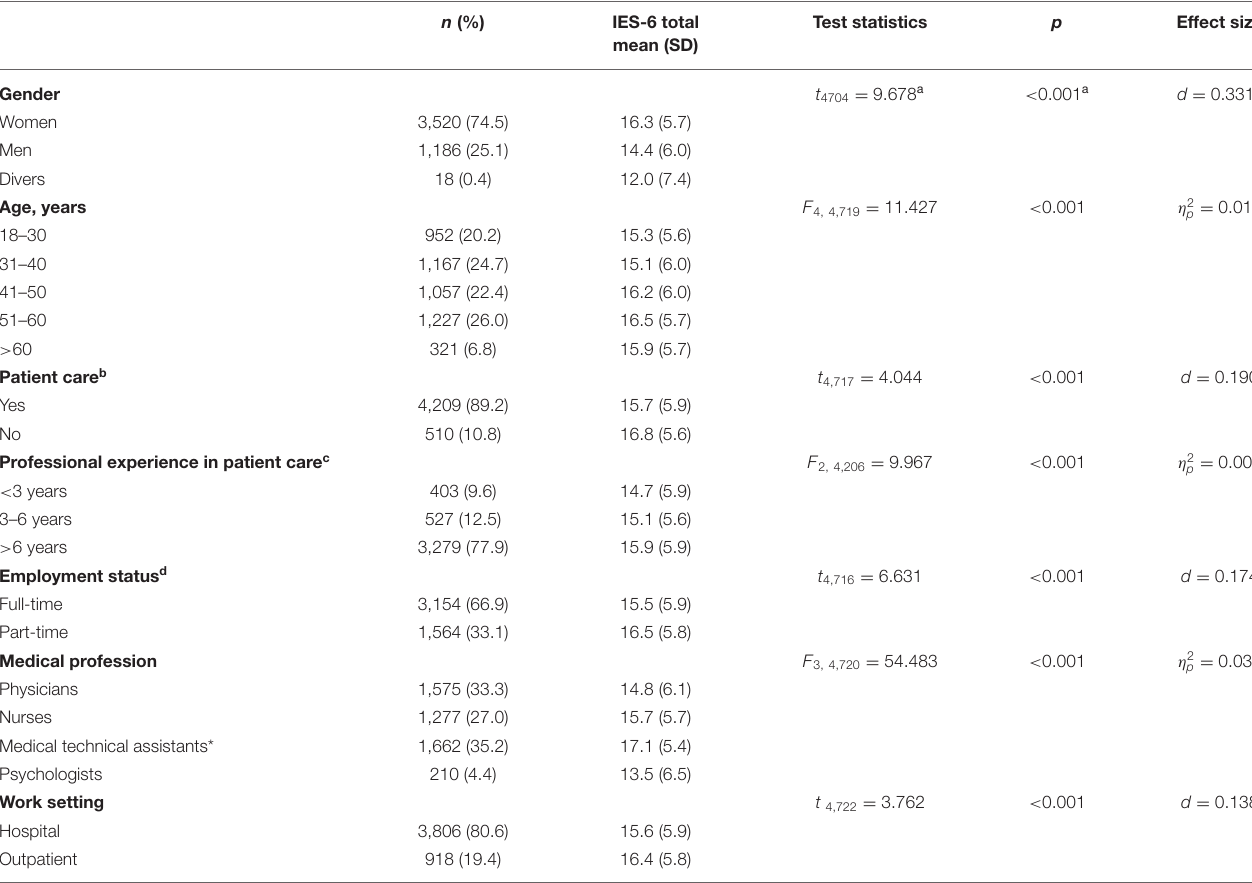
TABLE 1 | Group differences in PTSD symptoms with regards to sociodemographic and occupational characteristics among the sample of healthcare workers ( N =